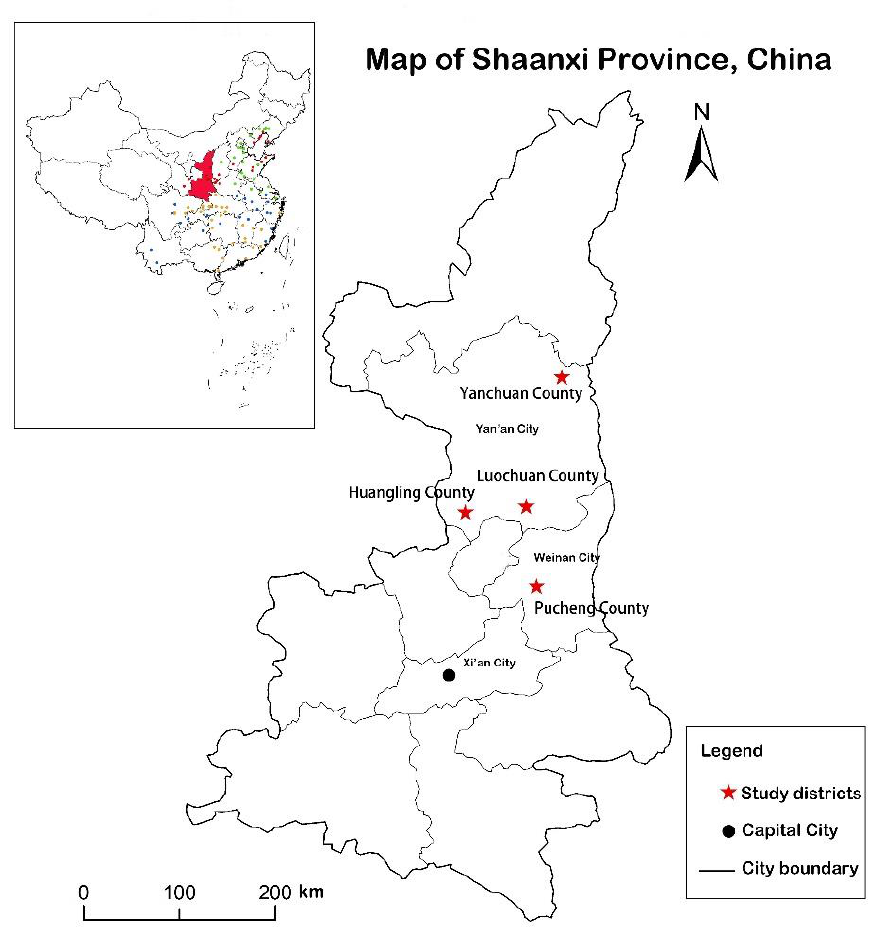
Figure 2. Description of the study area.